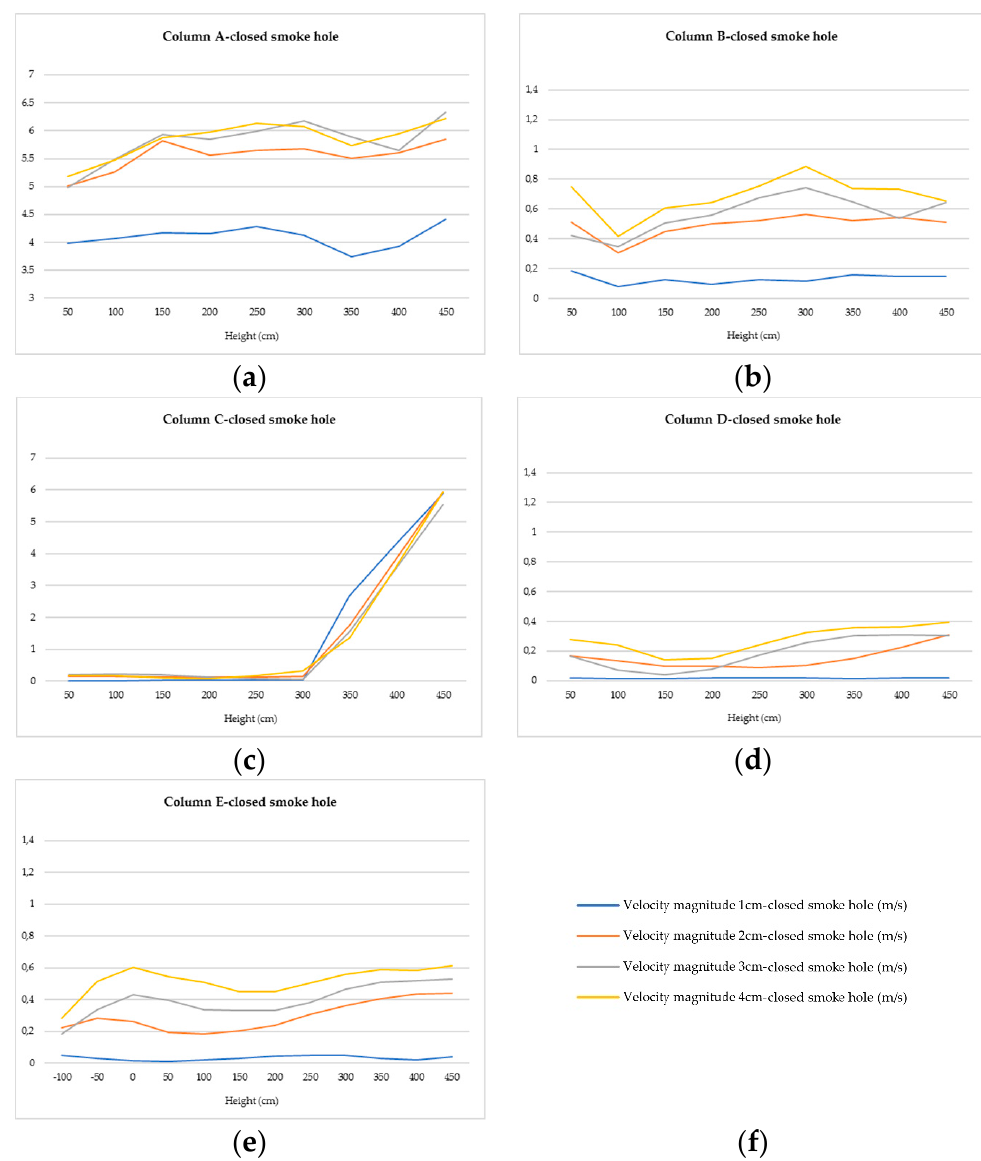
Figure 8. Values of velocity for the five columns of points, which is analyzed when the smoke hole of the plank house is opened (m/s) (Microsoft Excel ® ; Autodesk CFD ® ).